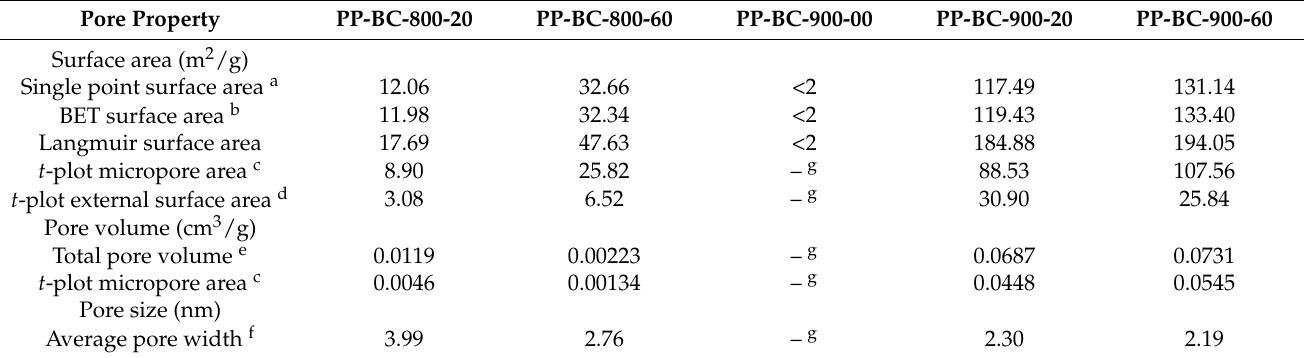
Table 2. Pore properties of resulting biochar